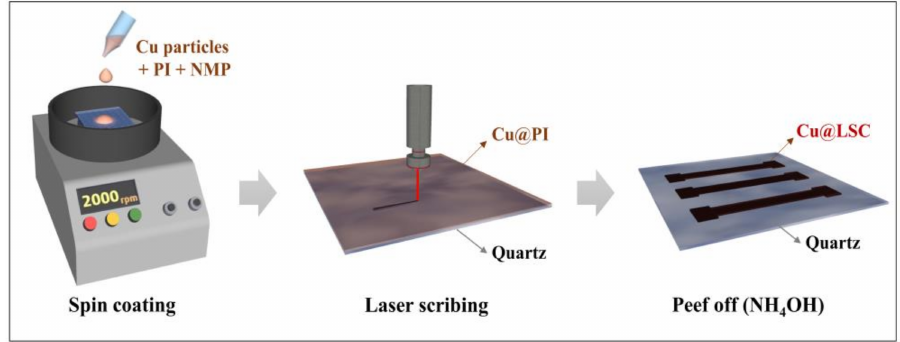
Figure 1. Schematic illustration of synthesis process of